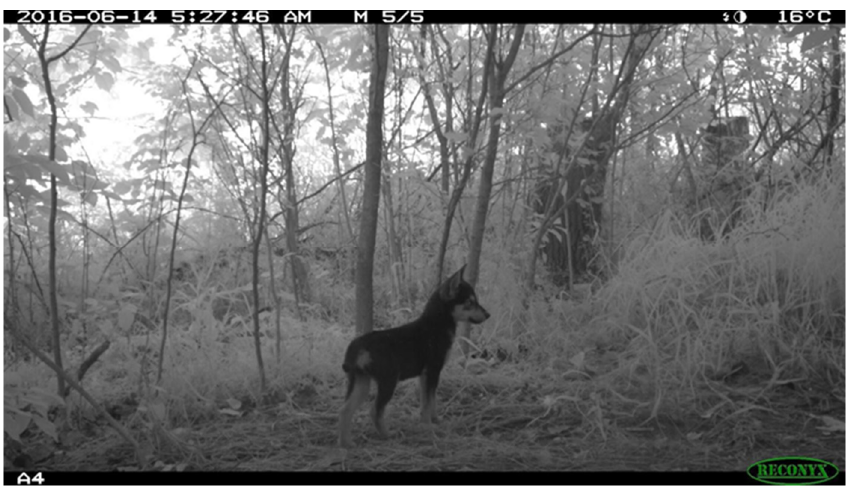
Figure 1. Trail camera photograph of a pup in the Elmjack coyote pack. Pelage pattern is unusual for a coyote and suggestive of domestic dog ancestry (Photo credit: Gotham Coyote Project).